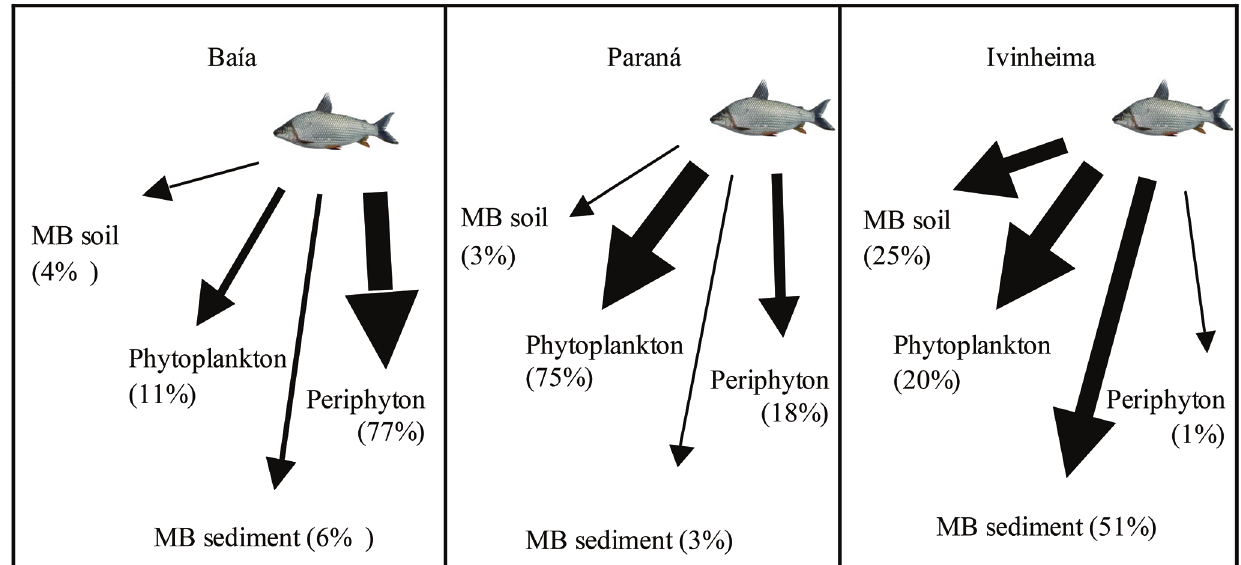
Fig. 4. The average percentage contribution of each carbon source in different subsystems. The width of arrows represents the strength of resource utilization in each environment studied (MB = microbial